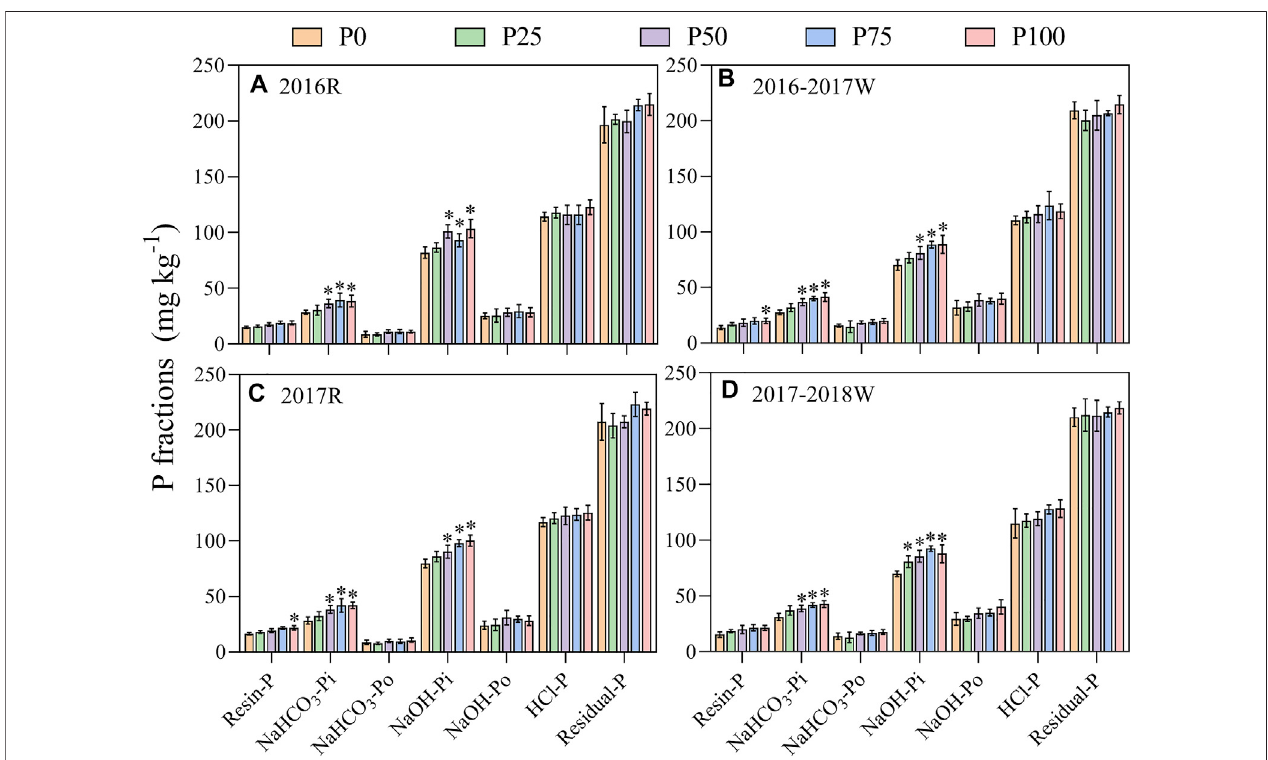
FIGURE 2 | Variations in sequentially extracted P fractions under P fertilization rates on two-year rice-wheat rotation paddy fi eld from 2016 to 2018.